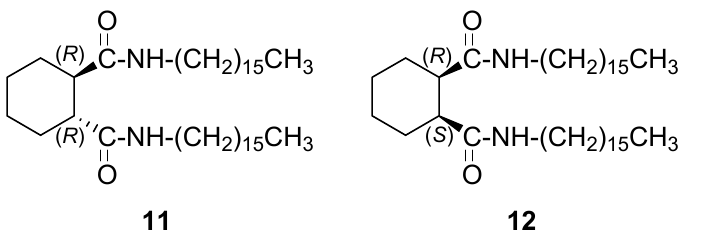
Figure 7. Cyclohexane-containing bisamides based on cyclohexane-1,2-dicarboxylic acid. These compounds were synthesized by means of standard peptide coupling